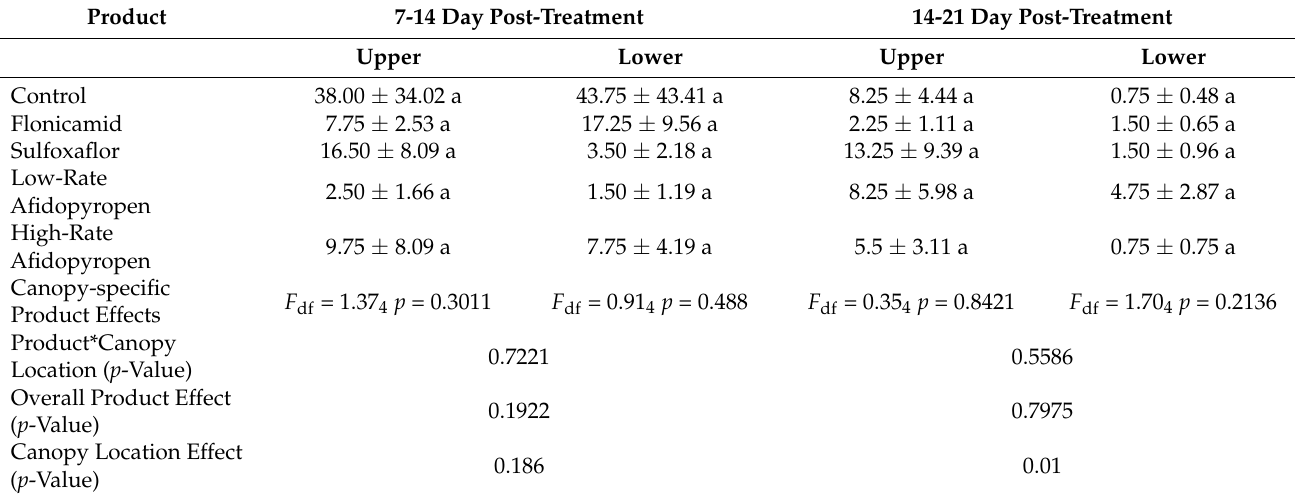
Table 3. Mean ± SEM of adult parasitoids per card across treatments and sample days in 2019. Differing letters in columns indicate a significant difference between treatments ( p < 0.05 Tukey’s HSD). Canopy-specific product effects and p -values for product*canopy interaction, overall product effect, and canopy location across sampling days are also shown. Application rates for each aphicide are based on the standard label